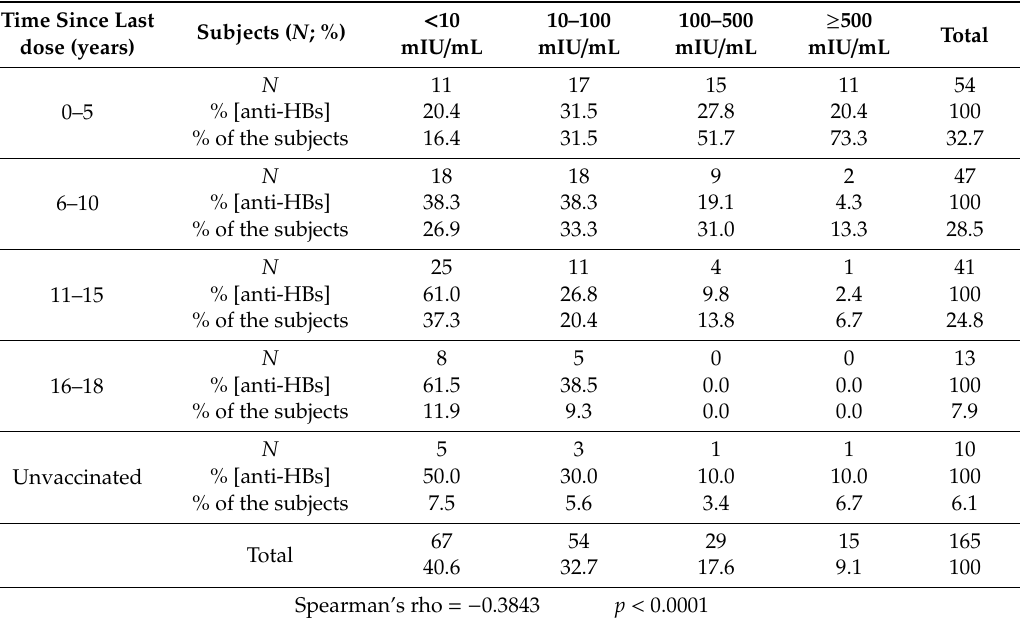
Figure 3. Immunity levels (anti-HBs) related to the years of the last anti-hepatitis B vaccine dose received. Table 3. Anti-HBs titer distribution related to the time elapsed since the last dose of an anti-hepatitis B vaccine received.